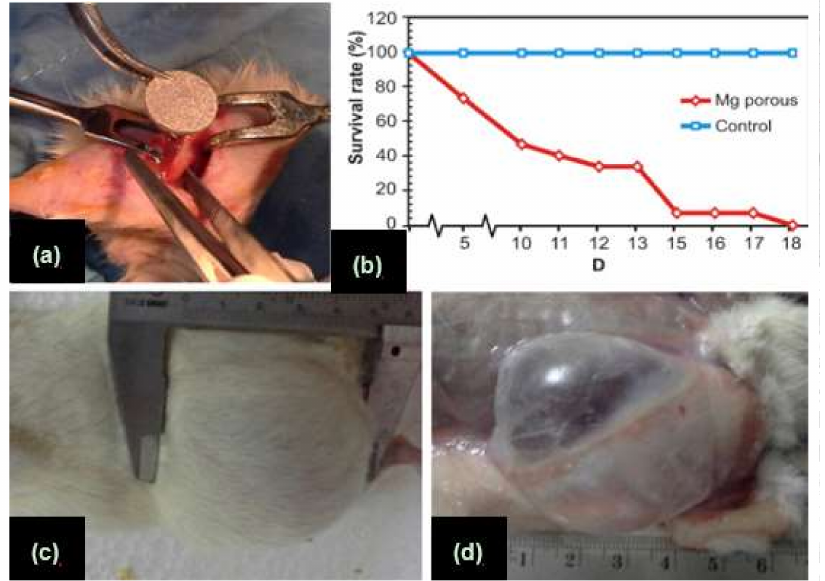
Figure 2. ( a ) Porous pure-magnesium implantation; ( b ) survival rate of the group of rats with magnesium implants compared with control group; ( c ) gas cavity formation; and ( d ) subcutaneous opening of the implantation area at Day 7, reproduced with permission from [41], Elsevier,